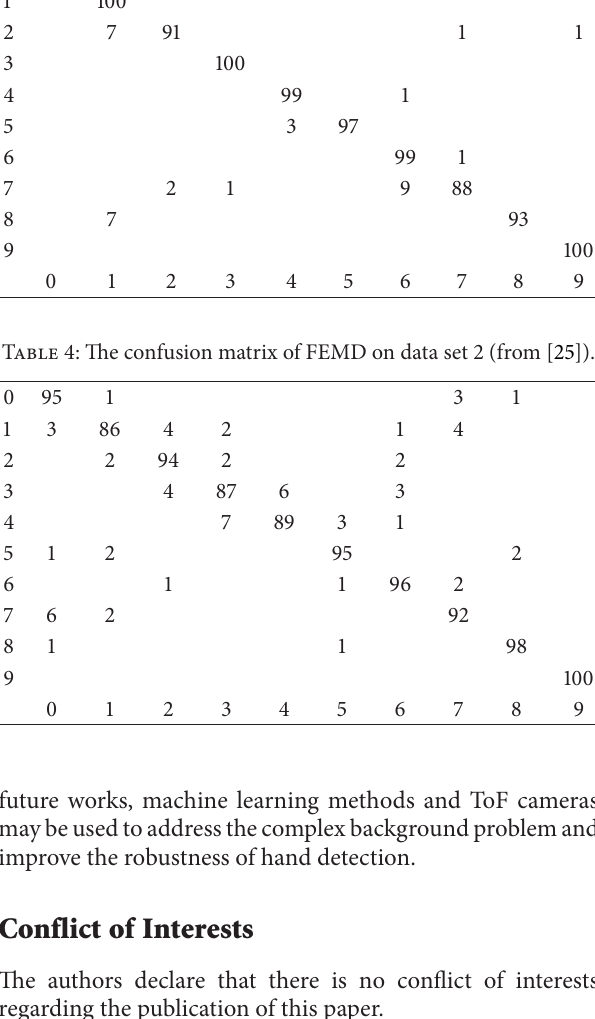
method for hand gesture segmentation and recognition using forward spotting scheme in conditional random fields,”